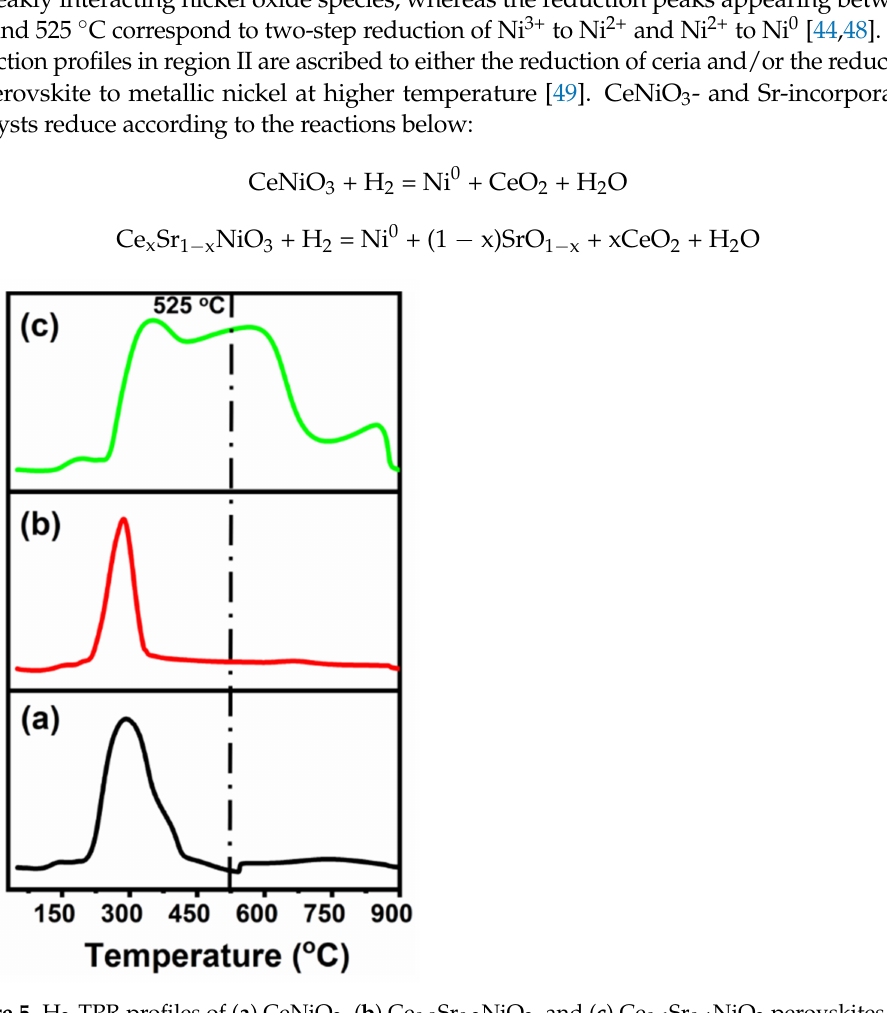
Figure 5. H 2 -TPR profiles of ( a ) CeNiO 3 , ( b ) Ce 0.8 Sr 0.2 NiO 3 , and ( c ) Ce 0.6 Sr 0.4 NiO 3